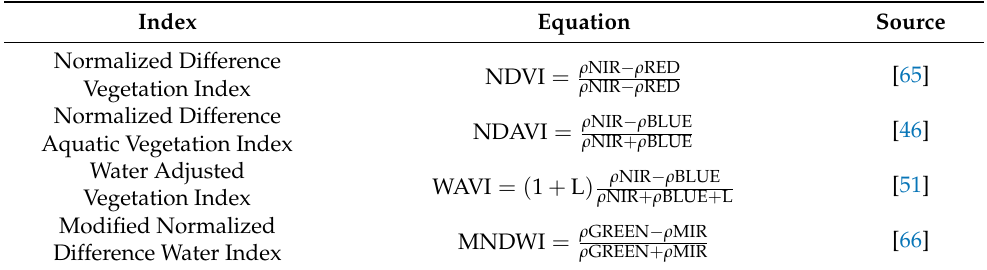
Table 1. Vegetation and water indices used for water and vegetation features